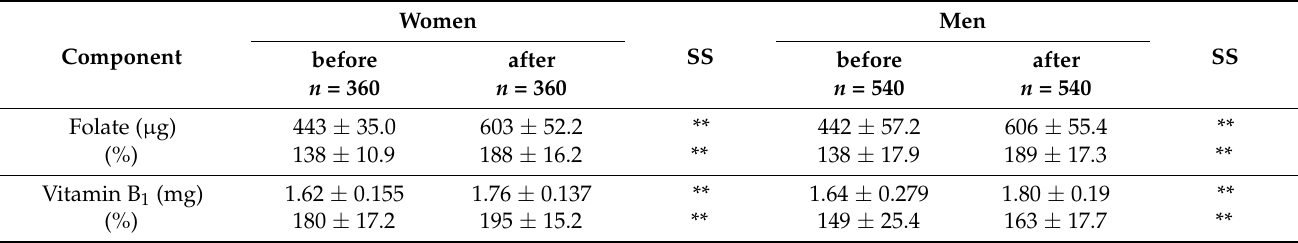
Table 3. Content of selected vitamins and minerals in all-day food rations, including disk remnants, − of women and men; x ± SD, % of the recommended